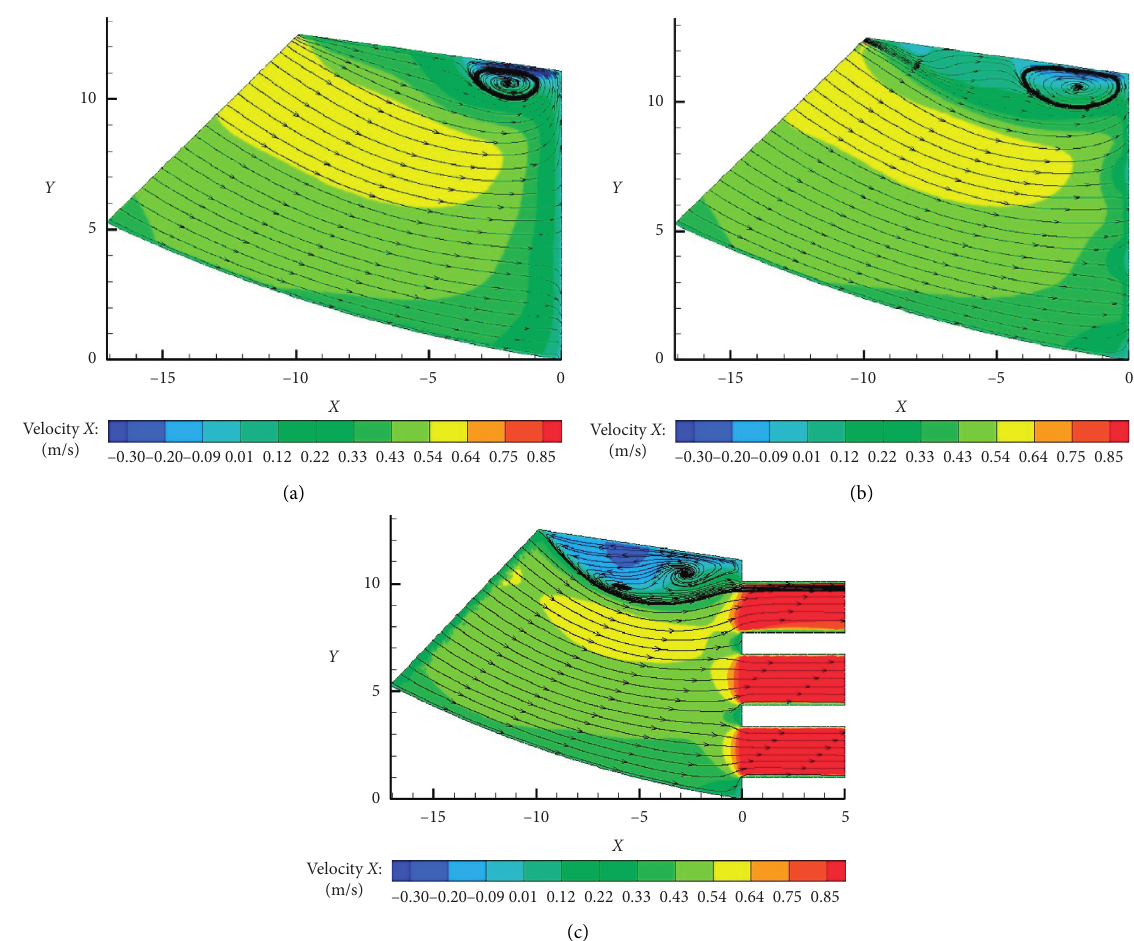
Figure 6: Velocity cloud diagram of the flow field in each horizontal section at a 45 ° lateral angle. (a) Surface velocity flow field diagram (b) Midlevel velocity flow field diagram. (c) Bottom velocity flow field diagram.